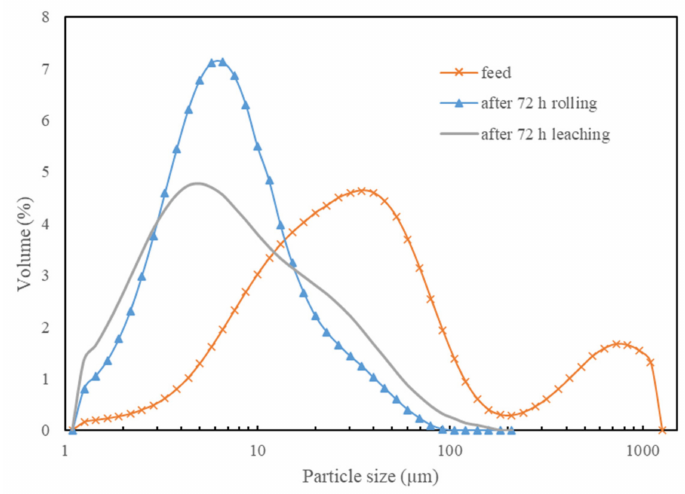
Figure 4. PSD of the feed and the residue after leaching (ceramic beads: solid = 3:5) and rolling without leaching (ceramic beads: solid =